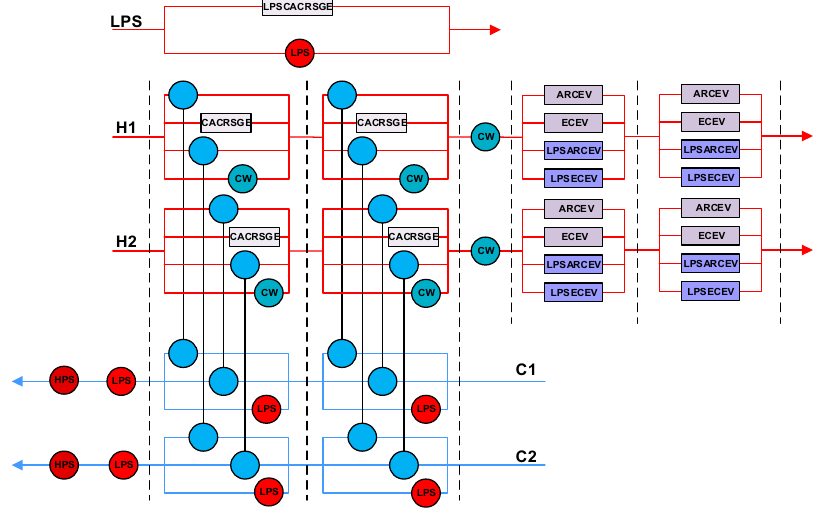
Figure 3. Superstructure of the heat exchanger network (HEN) integrated with CACRS.